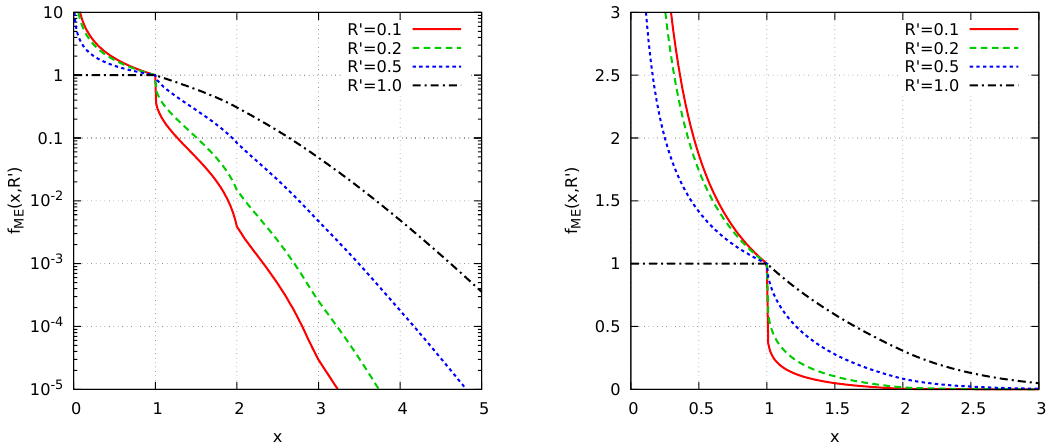
Figure 2 . Plot of f ME ( x; R 0 ) as a function of x for several representative values of R 0 in both logarithmic (left) and linear (right)